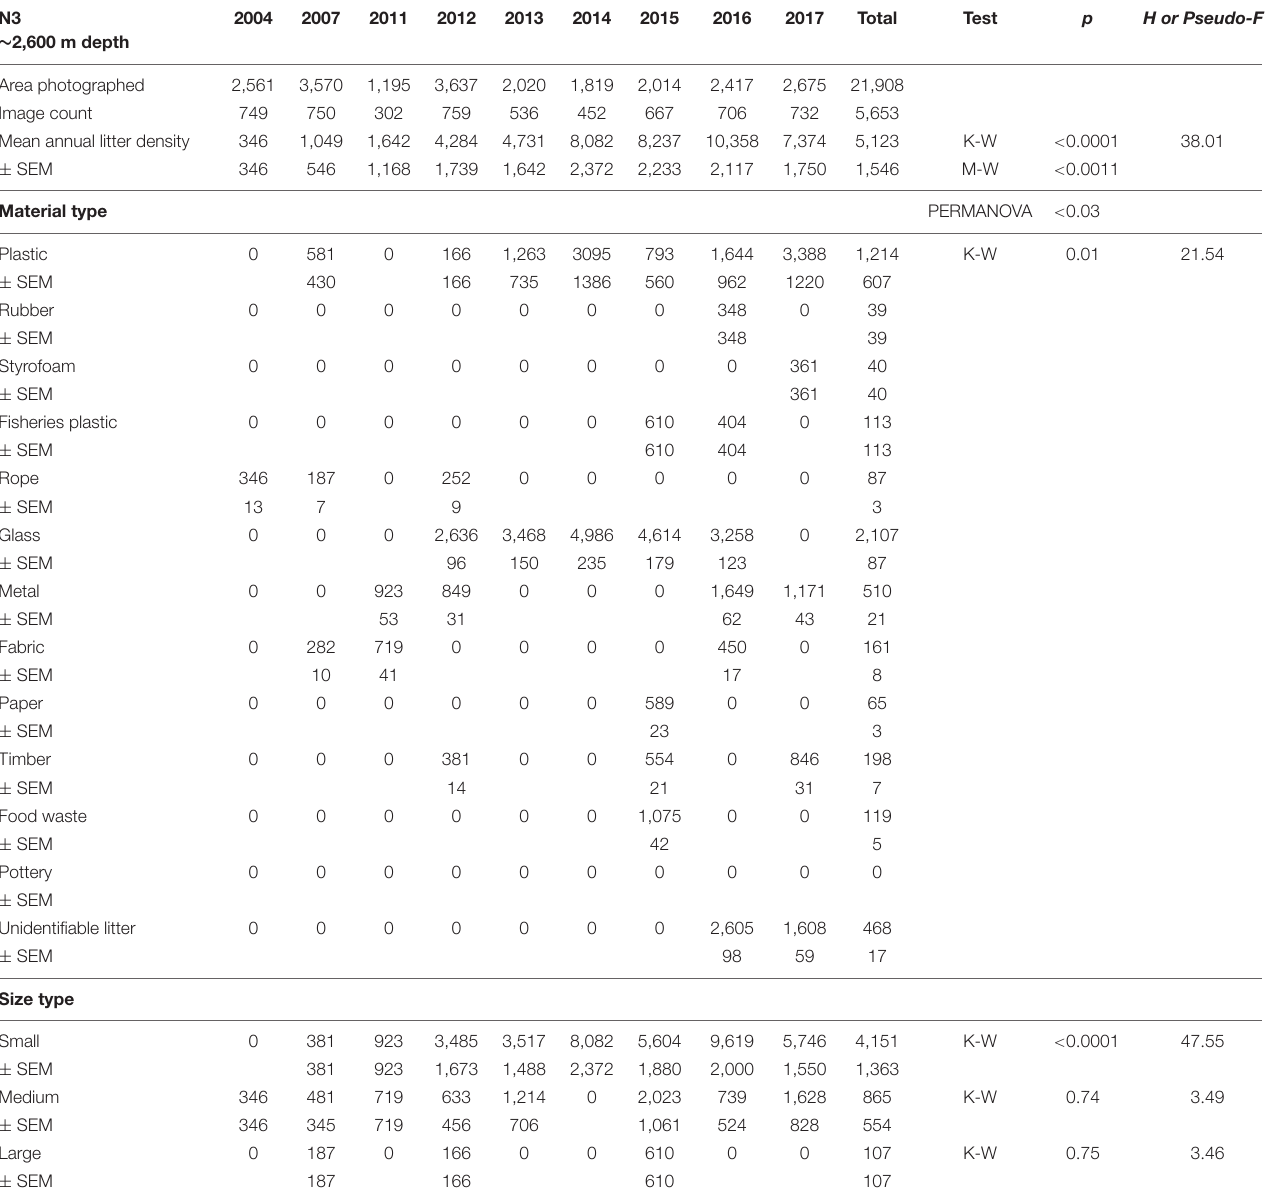
TABLE 3 | Summary of the area covered (m 2 ), mean annual litter densities (items km − 2 ), material and size composition at HAUSGARTEN station N3. N3 ∼ 2,600 m